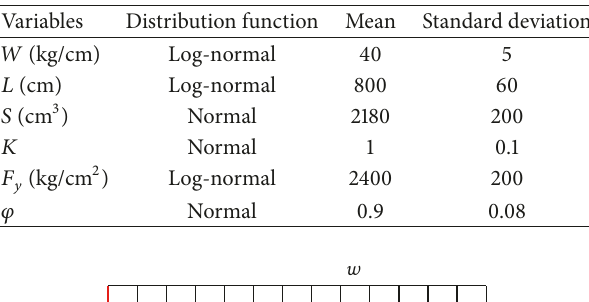
Table 3: Random variables for two-span beam.